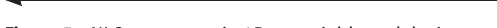
Figure 5: NLO processes in 2D material-based devices. (A) Schematic of local strain formed in monolayer MoS . (B) The schematic setup for polarized second-harmonic generation (SHG) 2 measurements. Inset: φ in the laboratory coordinate is the rotation angle of the sample and only the parallel component of the SHG signal is measured (A and B reproduced from [135] with permission from Nano Letters). (C) Schematic design of the hybrid integration of MoSe 2 onto a Si-waveguide. (D) Schematic side view of the grating coupler for both in- and out-coupling, where the numbers mark the physical dimensions in nm; bottom: SEM top view of the two grating couplers (C and D reproduced from [136] with permission from Nano Letters). (E) Schematic illustration of the proposed nonlinear metasurface. (F) Computed third-harmonic (TH) power outflow and TH generation conversion efficiency as functions of the incident fundamental frequency wave intensity. The TH power outflow is fitted by using a cubic power function presented by the blue dotted line (E and F reproduced from [137] with permission from Journal of Optics). (G) Schematic illustration of hybrid waveguides integrated with graphene oxide (G reproduced from [138] with permission from APL Photonics). (H) Optical microscope image of a set of waveguides. The extent of the graphene (under the contacts) is shown by the dashed lines. On top of this structure the polymer electrolyte is spin-coated (not in this image) (H reproduced from [139] with permission from ACS